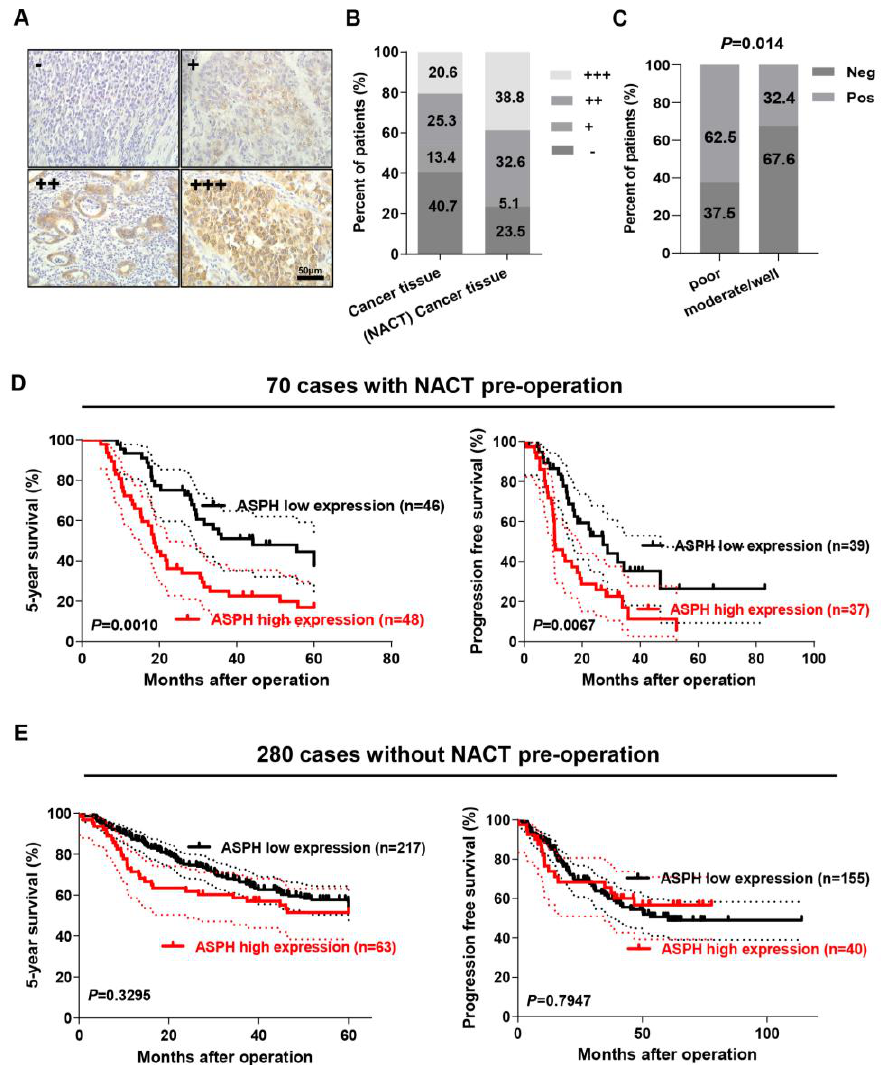
Figure 1. ASPH is upregulated in gastric cancer (GC) and is strongly associated with GC patients with NACT. ( A ) Immunostaining of ASPH in human gastric cancer tissues. Sections derived from GC patients with or without NACT were stained with ASPH and representative photos are shown. Scale bar: 50 μ m . ( B ) The staining score of ASPH expression in GC tissues with or without NACT pre-operation. ( C ) IHC staining indicated that the proportion of ASPH expression in poor vs. moderate/good differentiation of GC. ( D ) Kaplan – Meier analysis for the association of ASPH expression levels with 5-year survival ( left ) and progression-free survival ( right ) time in GC patients with NACT. The dot line represents the 95% confidence interval. ( E ) Kaplan – Meier analysis for the association of ASPH expression levels with 5-year survival ( left ) and progression-free survival ( right ) time in GC patients without NACT. The dot line represents the 95% confidence interval. All data indicate the mean ± SD.